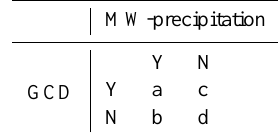
Table 1. Contingency table for the definition of Probability of De- tection (POD), False Alarm Rate (FAR) and Equitable Threat Score (ETS). Success Y is contemporaneous presence of precipitation for the selected pixel both from AMSU-based retrieval and from PM- GCD